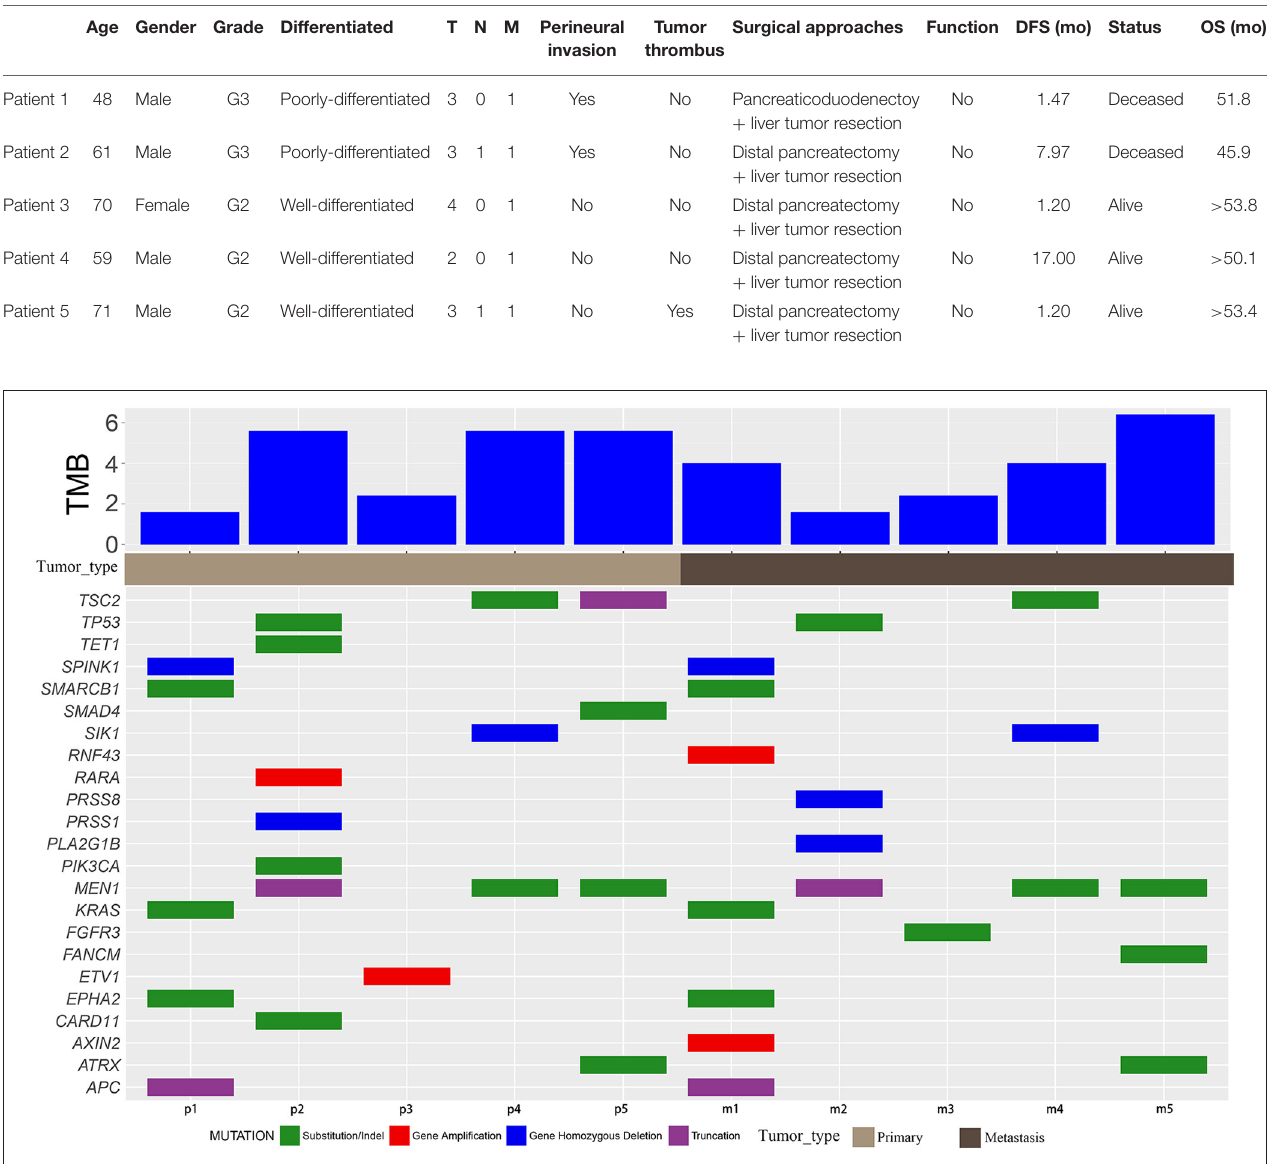
FIGURE 2 | Mutation characteristics and TMB. Mutation details of primary (p) and metastatic (m) samples of patients 1–5. Green blocks represent substitution/indel. Red blocks represent gene amplification. Blue blocks represent homozygous gene deletion. Purple blocks represent